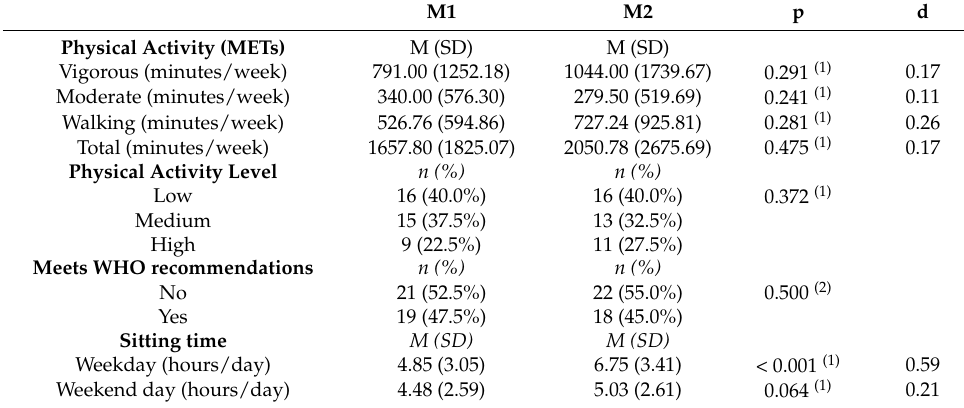
Table 3. Physical activity and sitting time in M1 and M2 ( n =